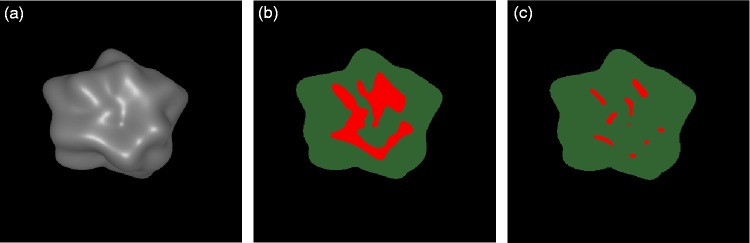
(a) Example of a test stimulus (here one half-image of the stereo pair). (b) The
respective matching stimulus with the biggest possible extension of the highlight
pattern (red areas). (c) Example matching result for the perceived sizes of the
highlights in (a).